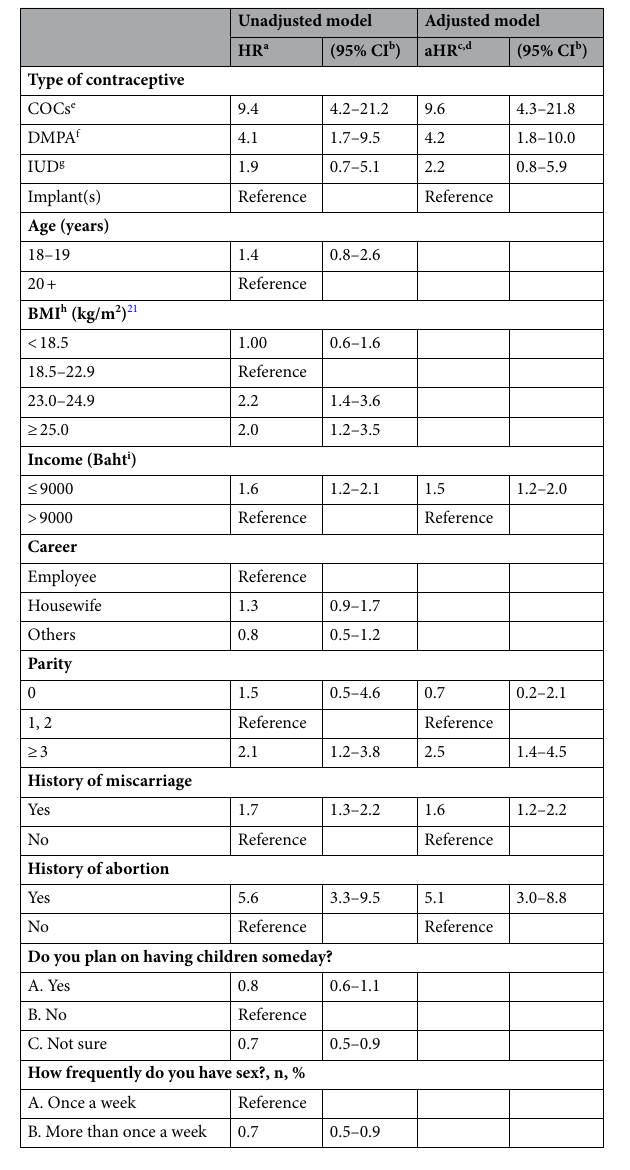
Table 3. The unadjusted and adjusted hazard ratios from the Cox proportional hazards model. a HR: Hazard ratio. b CI: Confidence interval. c aHR: Adjusted hazard ratio. d Adjusted for type of contraceptive, income, parity, history of miscarriage, and history of abortion. e COCs: Combined oral contraceptive pills. f DMPA: Depot medroxyprogesterone acetate. g IUD: Copper intrauterine device. h According to the Asian BMI category, < 18.5 was defined as underweight, 18.5–22.9 was defined as normal weight, 23.0–24.9 was defined as overweight, and ≥ 25.0 was defined as obese 18 . i 1 US dollar equals 31.25 Thai baht